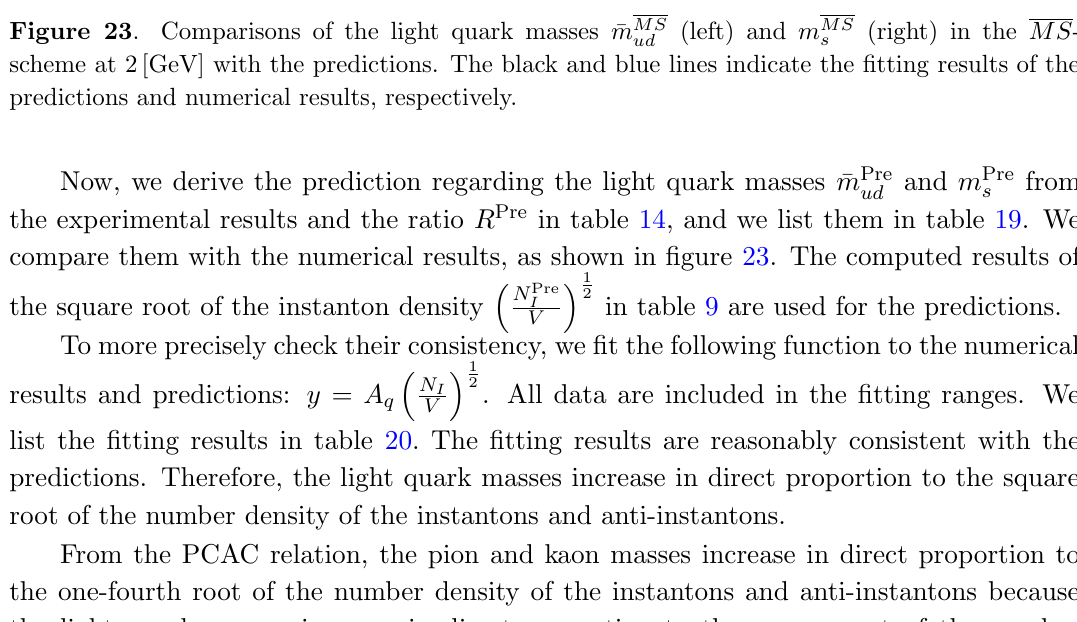
(left) and m MS (right) in the MS - s ud